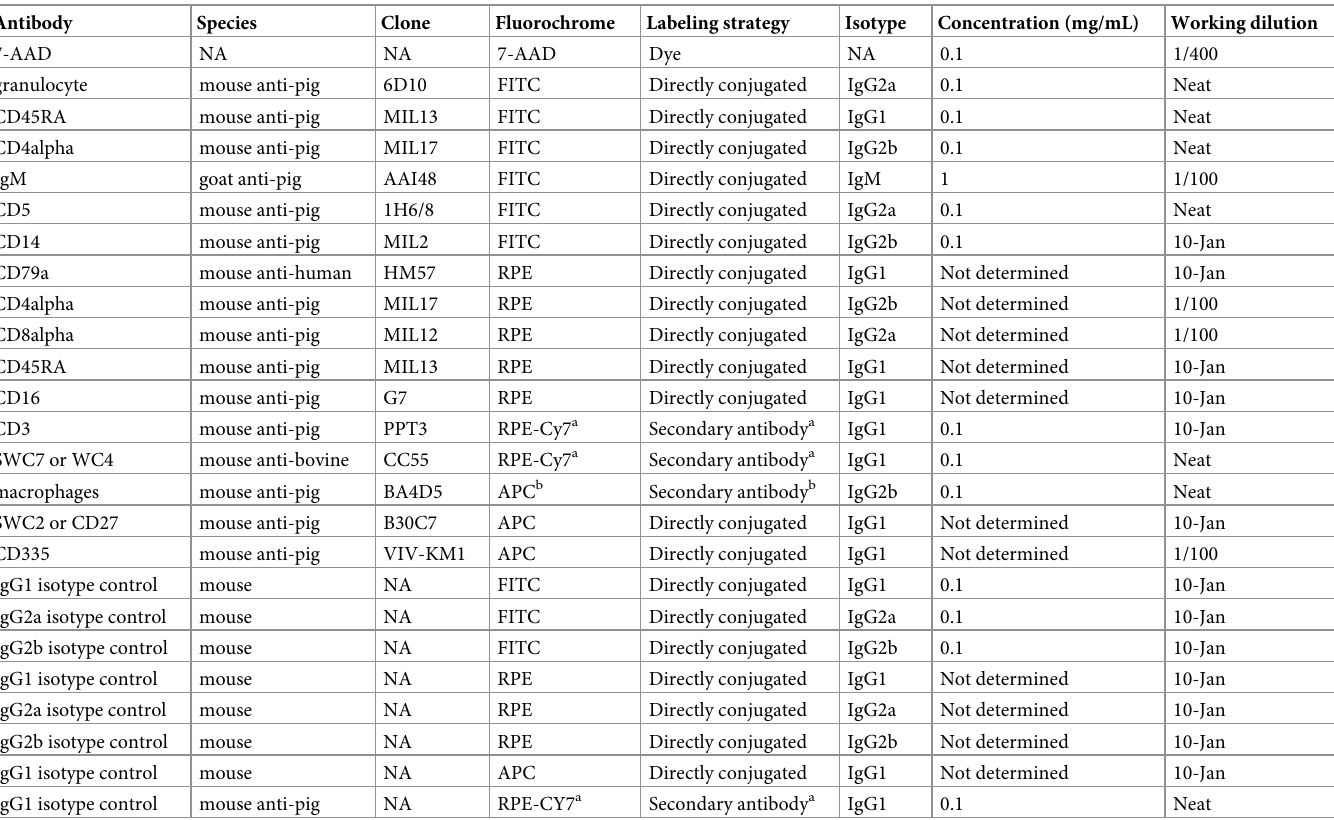
Table 1. Antibodies used in flow